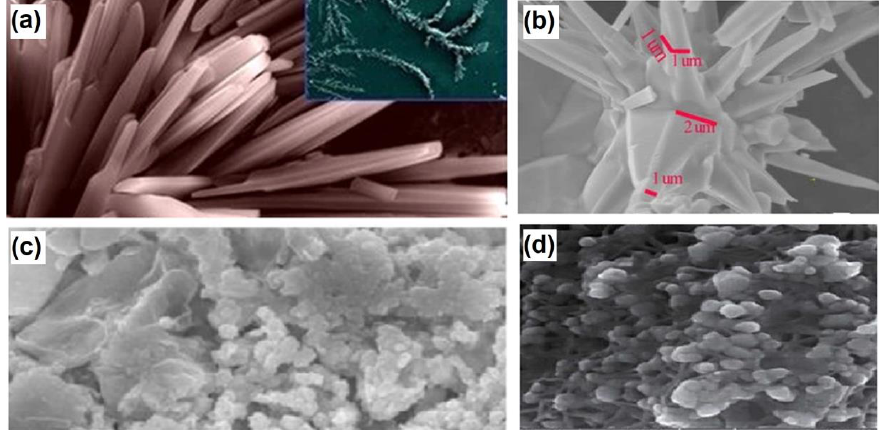
Figure 7. SEM images of different sol–gel synthesized ZnO nanostructures. ( a ) Thorn-like, ( b ) flower petals, ( c ) semispherical, and ( d ) spherical. Reproduced with permission from